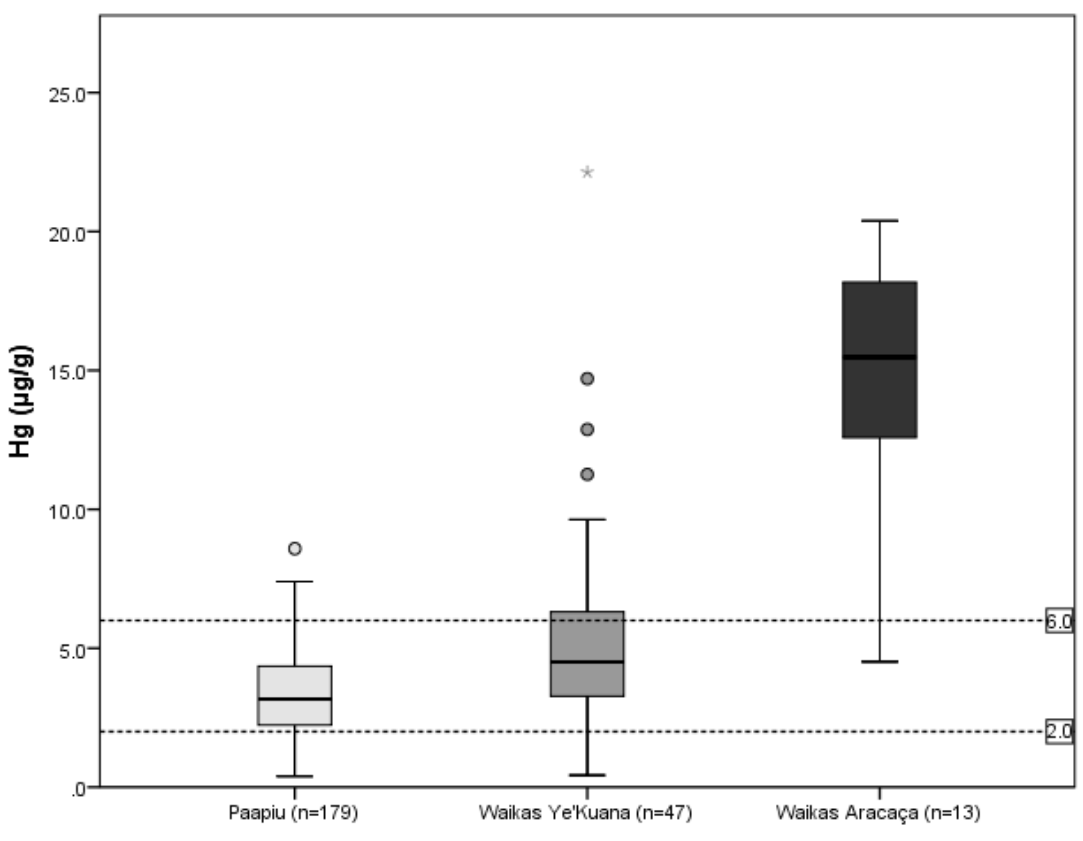
Figure 2. Distribution of total mercury concentration ( µ g · g − 1 ), according to villages: Yanomami reserve, Roraima, Amazon, Brazil, 2014. A significant difference was observed among the three groups (K-W test; p -value < 0.001).